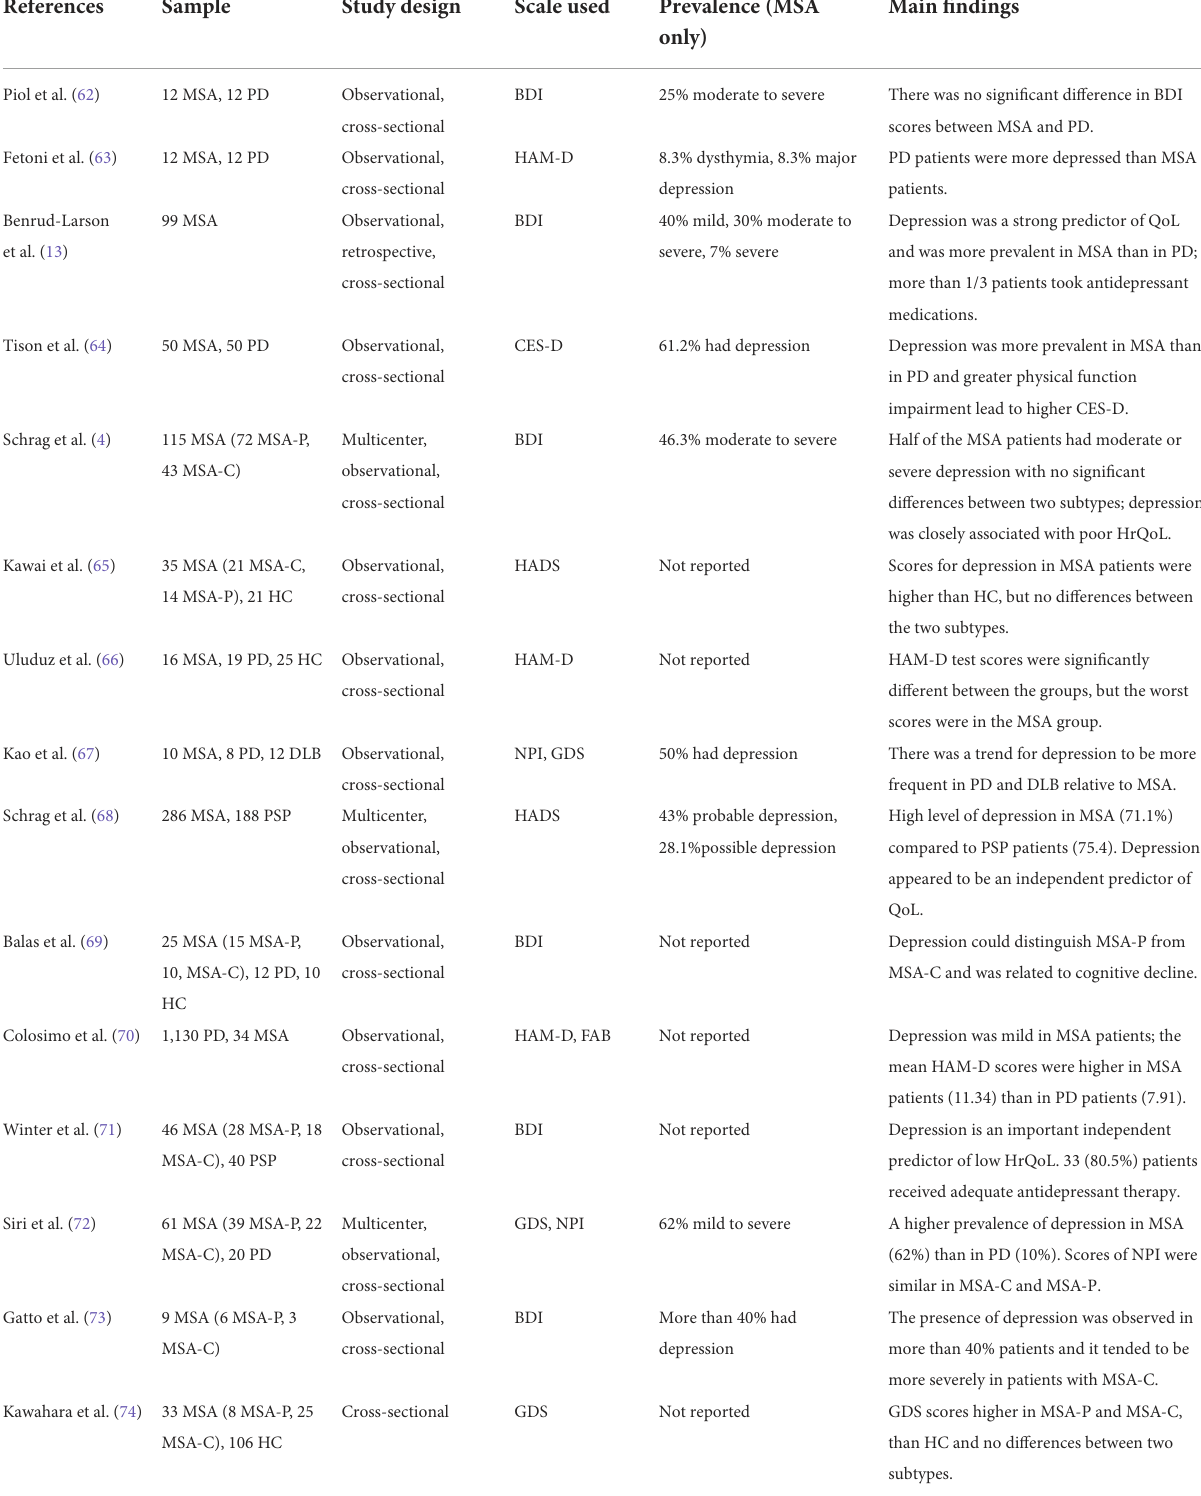
TABLE 1 Overview of studies reporting clinically relevant depression in